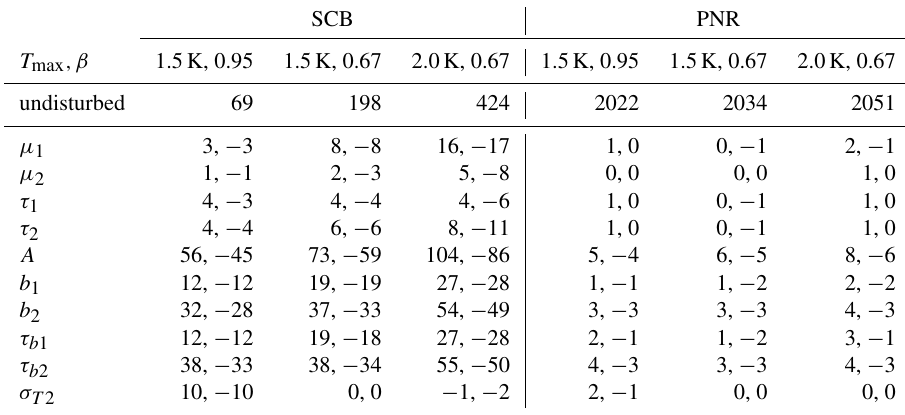
Table 5. Sensitivity of the safe carbon budget (SCB) and point of no return (PNR) to selected parameter variations. Values as difference inGtC (SCB) and number of years (PNR) relative to the undisturbed value (top row). The PNR values all refer to the EM scenario. First and second numbers give 10% parameter decrease and increase,